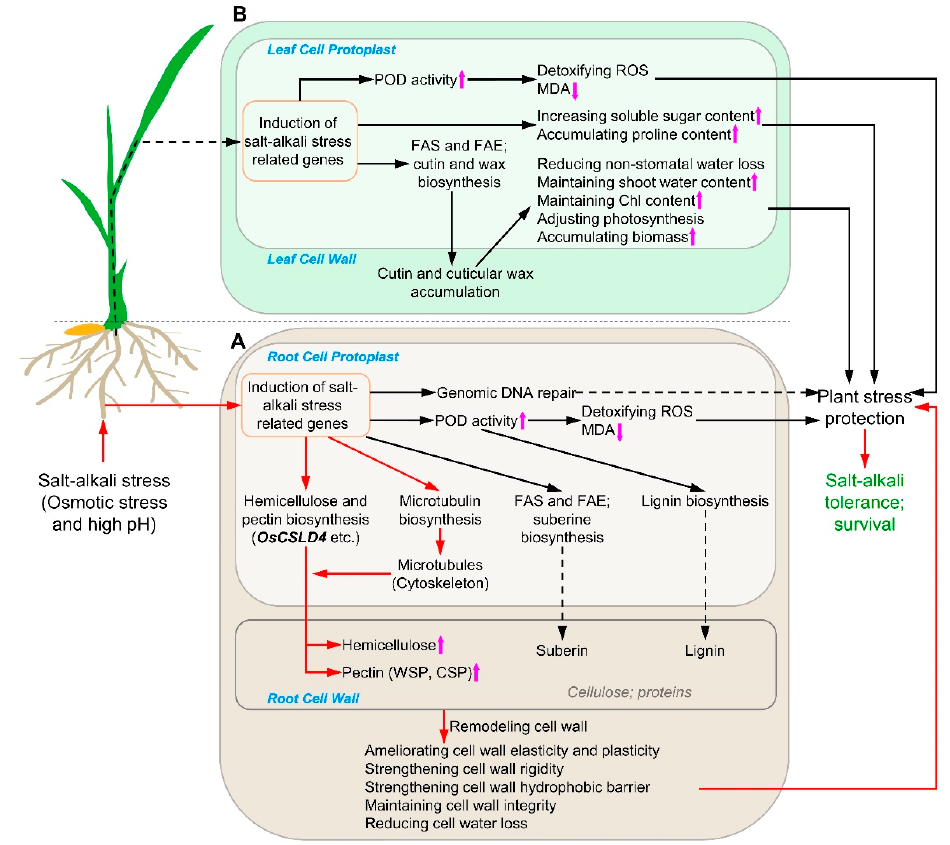
Figure 9. A proposed model depicting how SATR adapts to salt–alkali stress. ( A , B ) The metabolism pathways, regulatory networks and molecular mechanisms depicting how SATR seedlings adapt to salt–alkali stress in roots ( A ) and shoots ( B ), respectively. Solid arrow and dashed arrow indicate sequential step (or process) and predicted sequential step (or process) in the metabolism pathways and regulatory networks, respectively. The metabolism pathways and regulatory networks along with the red arrows are the most key pathways and regulatory networks which modulate salt–alkali tolerance of SATR. Purple up or down arrow indicates corresponding component content is signif- icantly higher or lower in SATR seedlings than 93-11 after SSAS, respectively. Chl, chlorophyll; WSP, water-soluble pectin; CSP, covalently soluble pectin; FAS, Type II fatty acid biosynthesis; FAE, fatty acid elongation; MDA, malondialdehyde; POD, peroxidase; ROS, reactive oxygen species. After the salt–alkali stress signal is transduced into root cell protoplast, expressions of some salt–alkali stress-related genes are activated (Figure 9A). For example, expres- sions of DNA repair genes are activated in the nucleus to repair the DNA damage resulted from salt–alkali stress. This DNA repair mechanism is supported by our result that the nucleotide base and excision repair pathways were significantly enriched from the upreg- ulated DEGs between SATR and 93-11 on the 2nd day after SSAS treatment (Figure S8A), which suggests that SATR seedlings may have stronger ability to repair the DNA damage in root cells to cope with salt–alkali stress than 93-11. Besides, some physio-biochemical processes could be activated to deal with oxidative stress in the root cells triggered by salt–alkali stress. For instance, POD is a key antioxidase involved in detoxification of ROS [40]. SATR seedlings had higher POD activity on the 0th, 2nd and 4th days after SSAS treatment but lower MDA content than 93-11 on the 4th day after SSAS treatment (Figure 1L,M), which suggests that SATR has stronger ROS scavenging ability to reduce the oxi- dative stress in the root cells. This deduction is also supported by the result that the oxi- dation–reduction process is the most significantly enriched GO BP (GO biological pro- cesses functional category) term from the downregulated DEGs on the 2nd and 4th day